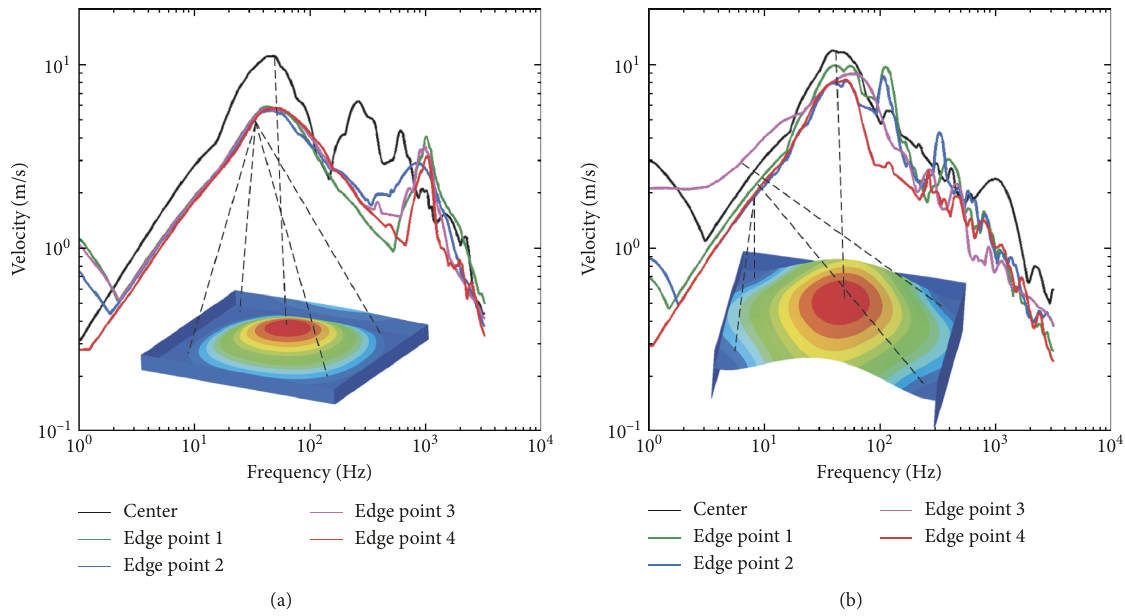
Figure 9: Impact environment in the single plate under working condition 2. (a) Bottom plate. (b) Upside plate.